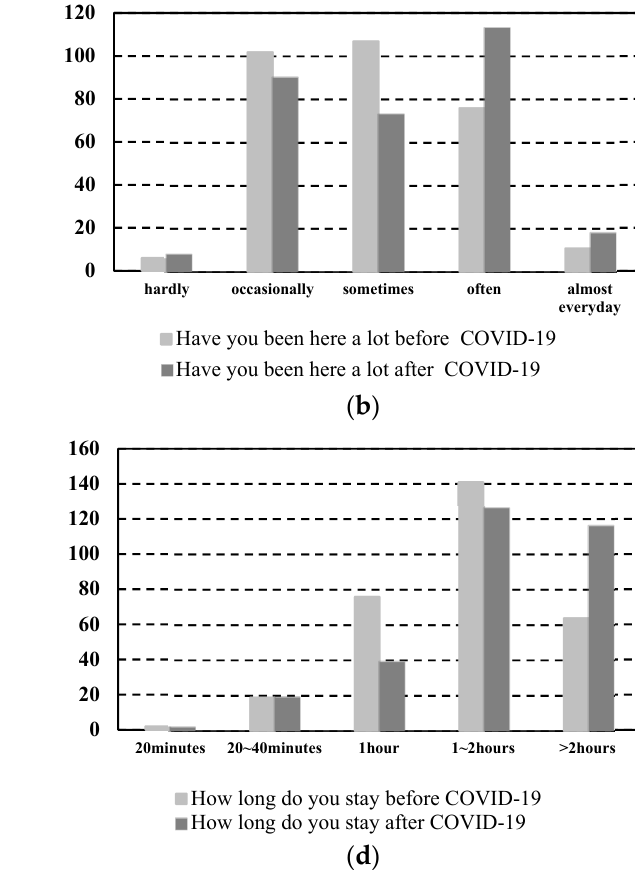
Table 4. Paired sample t -test results of physical and mental health before and after the pandemic. Paired Difference t p (Before vs Post) Before - Post -